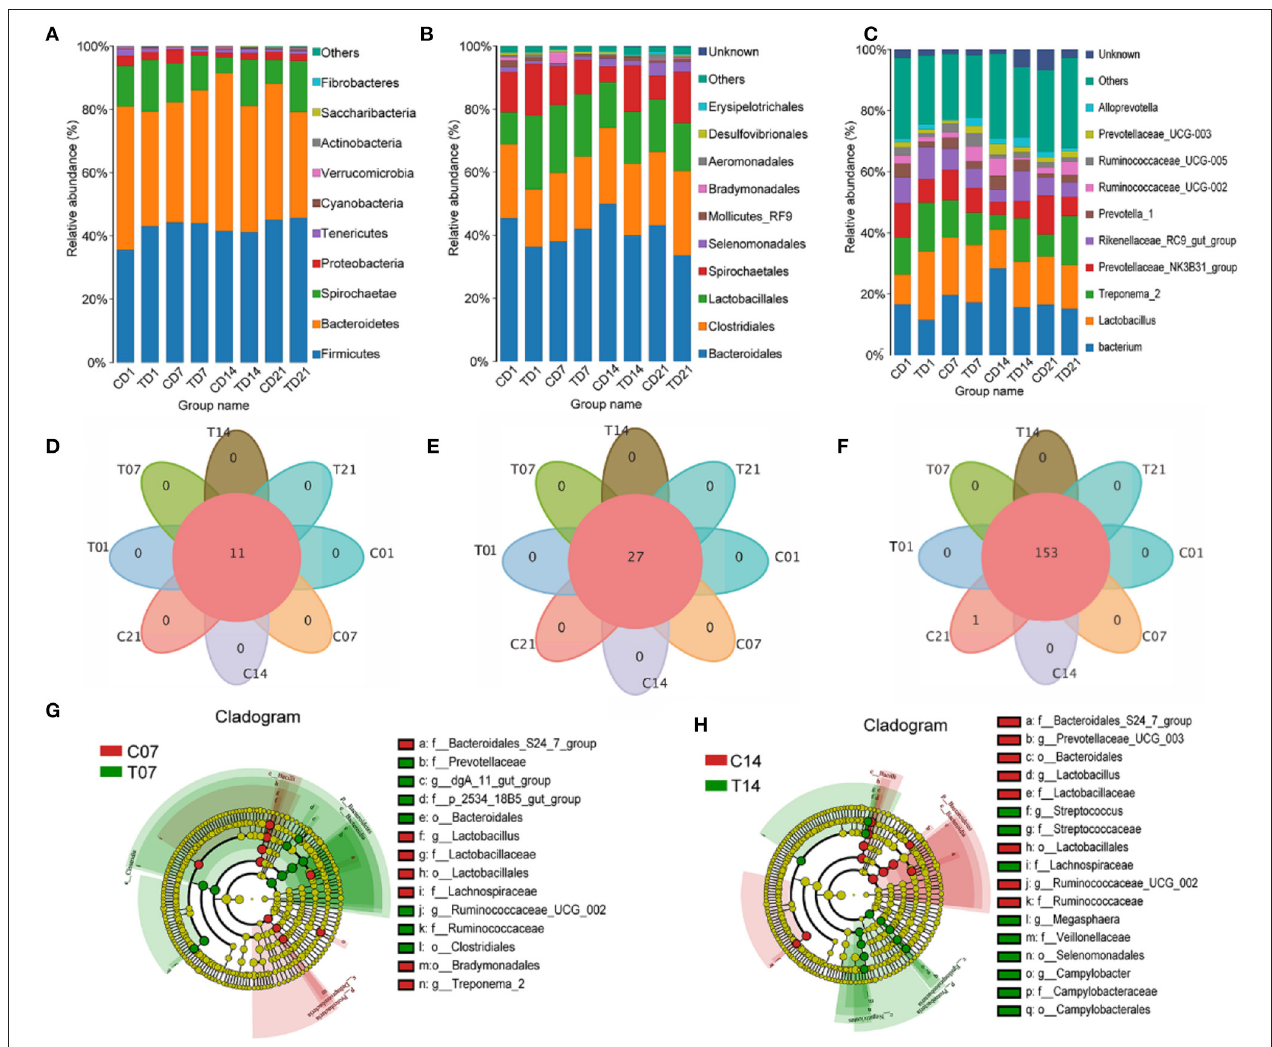
FIGURE 5 | Effects of heat stress on pigs’ colonic species composition. (A) Intestinal microbiota by phylum; (B) Intestinal microbiota abundance by order; (C) Intestinal microbiota abundance by genus; (D) Venn analysis by phylum; (E) Venn analysis by class; (F) Venn analysis by genus; (G) LEfSe analysis - day 7; (H) LEfSe (Line Discriminant Analysis Effect Size) analysis - day 14. C and T refer to control and HS pigs respectively; 1, 7, 14, and 21 refer to sampling days for pig feces and mouse transplantation of pig feces. Only the results with an LDA (Line Discriminant Analysis) significant threshold of > 4 are